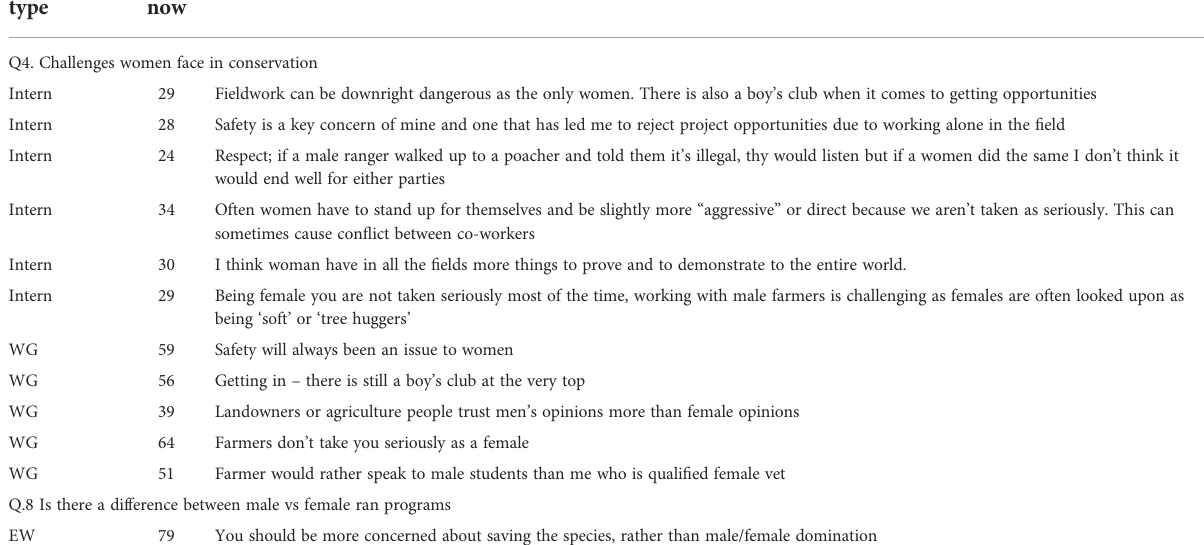
TABLE 4 Noteworthy survey responses from female